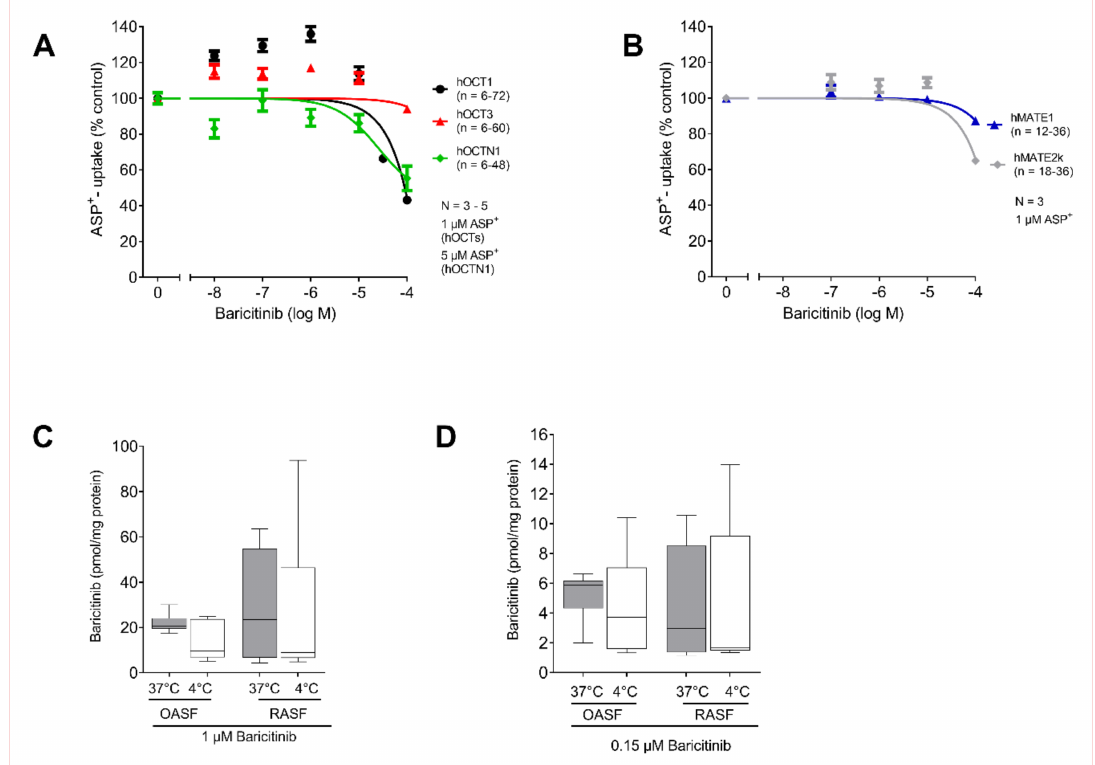
Figure 2. Baricitinib uptake is not transporter dependent. ( A ) ASP + determined apparent a ffi nity of Baricitinib to hOCT1, hOCT3 and hOCTN1. No significant interaction was observed ( n = 3–5). ( B ) ASP + determined a ffi nity of hMATE1 and hMATE2k after intracellular acidification ( n = 3). No significant interaction was observed. Data in ( A , B ) are presented as mean ± SEM and fitted using a non-linear fit. ( C ) LC / MS measurement of temperature dependent Baricitinib (1 µ M) uptake in RASF and OASF (F (1.332, 10.21) = 1.570; p = 0.2470; n = 3). ( D ) LC / MS measurement of temperature dependent Baricitinib uptake (0.15 µ M) in RASF and OASF (F (2.071, 16.56) = 0.44, p = 0.6578, n = 3). Statistical analyses were performed using a RM ANOVA. No post-hoc testing was performed, as the ANOVA was not significant. Data in ( C , D ) are presented as box plot with whiskers indicating the min and max values, as well as the